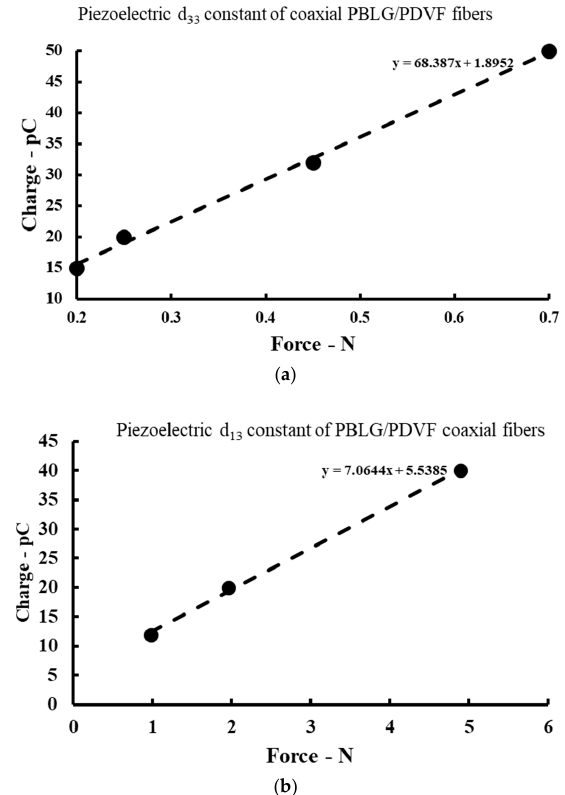
Figure 7. ( a ) The graph of the d 33 coefficient with the fitting line. The R 2 value is 0.9533. ( b ) The graph of the d 13 coefficient with the fitting line. The R 2 value is 0.9612.